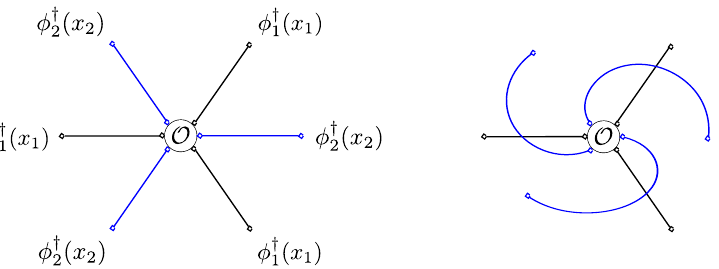
Figure 2 . Feynman graphs in the expansion of (4.18). For visual clarity the single-trace contribu- tion of the determinant pair is “smeared” in spacetime around O at the center. Colours stand for the “flavour” of the scalars (black for φ 1 and blue for φ 2 ) and the dots for the external fields. The intersections between the lines are ξ 2 -vertices. We represent the tree level (left) and an unwrapped spiral graph (right) for the three-magnon O = tr( φ 1 φ 2 ) 3